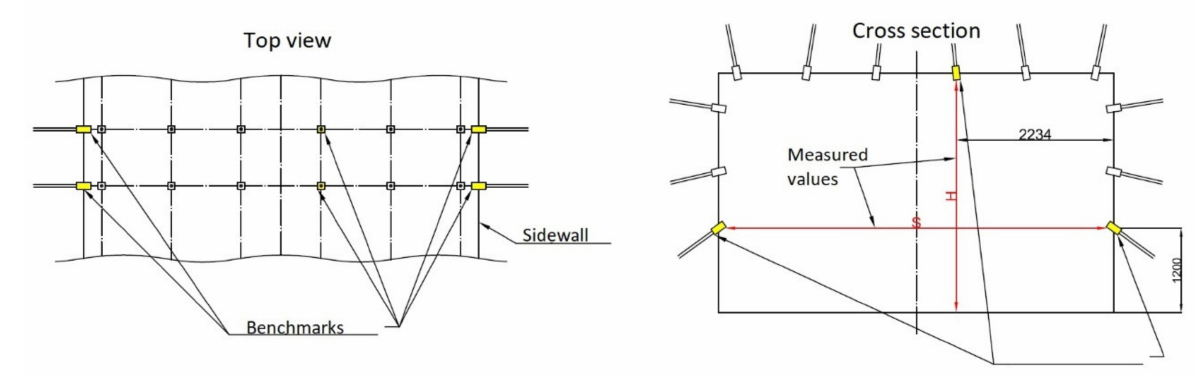
Figure 3. Cross sections of the convergence control station.